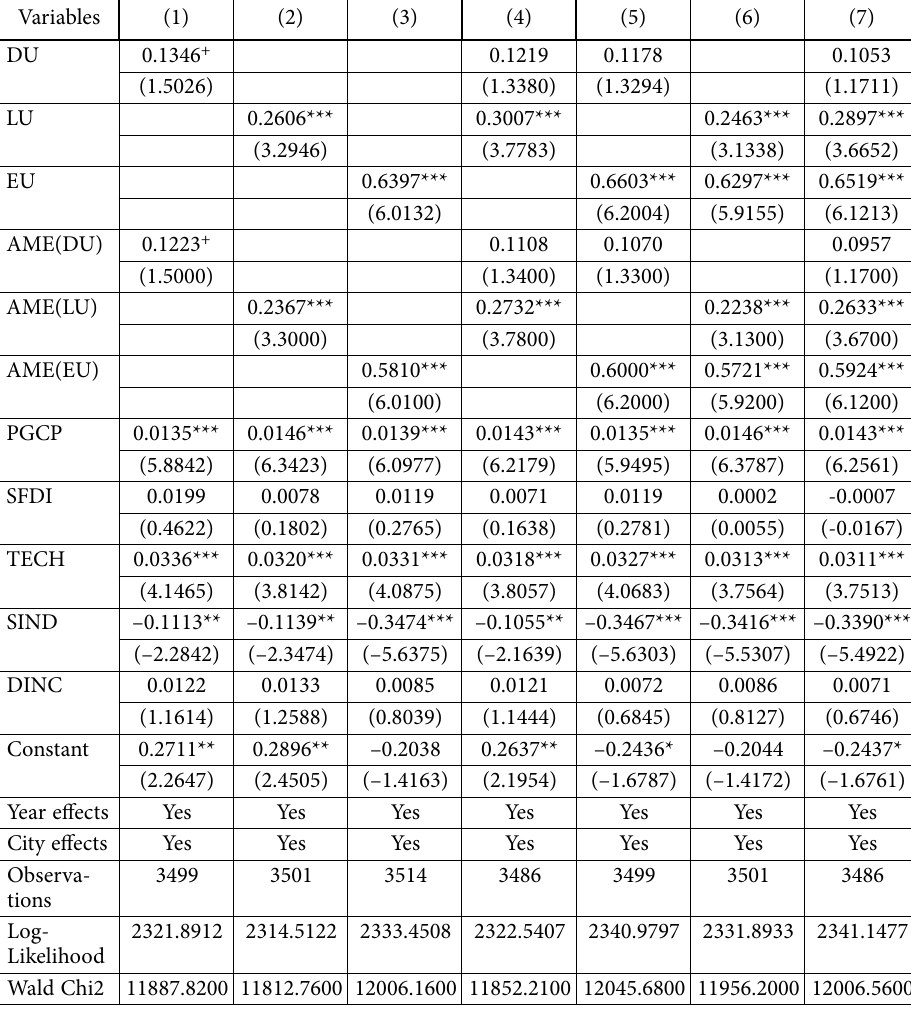
Table 4. Estimation results of Tobit models with fixed